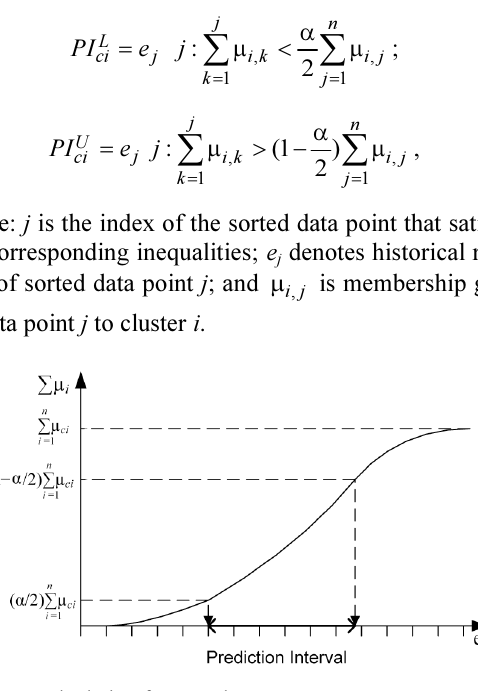
Fig. 7. PI calculation for one